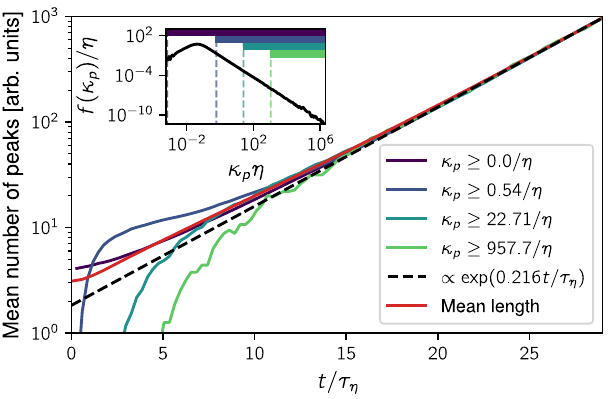
Fig. 3 Mean number of curvature peaks above different thresholds over time. The lines are vertically shifted for comparison, showing that the peaks are generated at a clearly de fi ned exponential rate. Moreover, the curves appear to be asymptotically proportional to the mean arc length of loops (red). The dashed line indicates an exponential fi t to the last third of the total peak number curve (violet), yielding the rate β = (0.21619±0.00014)/ τ η . The standard error of this rate is so small that we neglect it in the following. Note that without vertically shifting the curves in the plot, they would remain ordered as a function of the threshold condition. Inset: Curvature peak distribution at t = 29.15 τ η indicating the different thresholds.